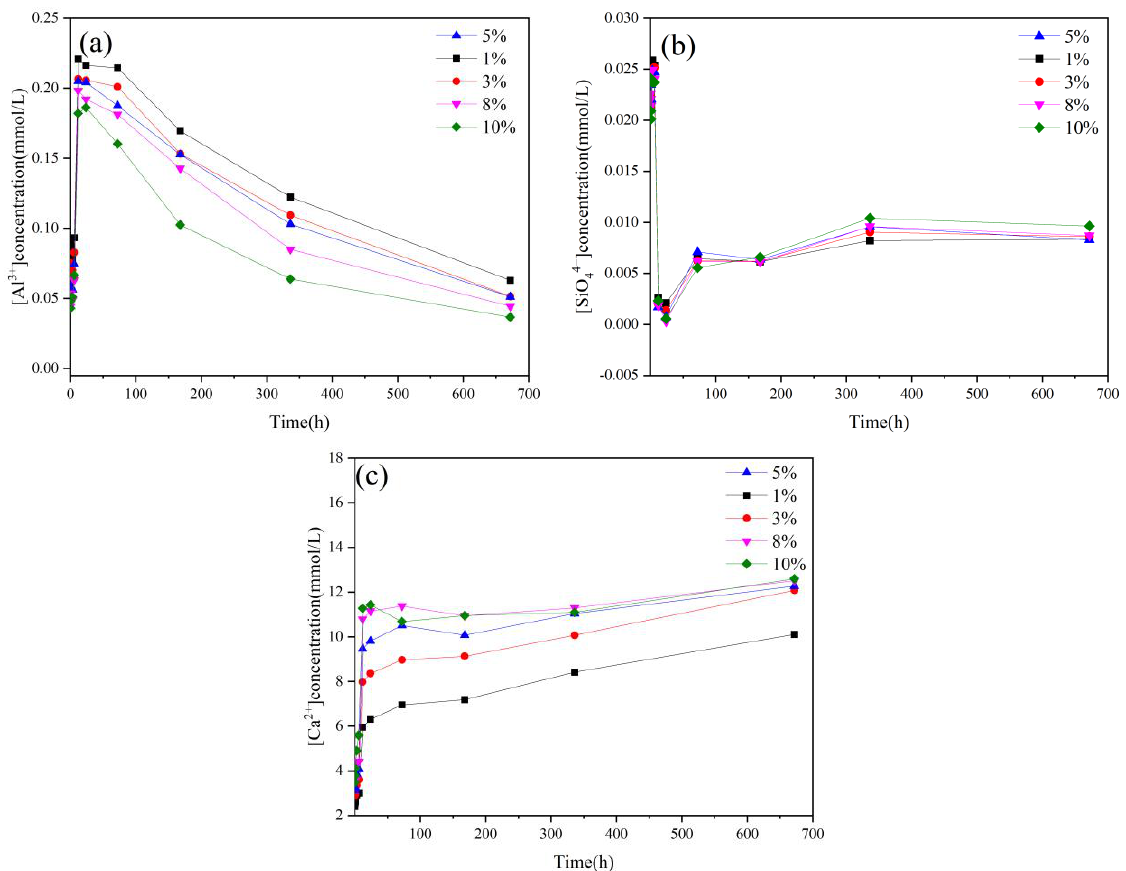
Figure 12. Ionic concentration of binders: ( a ) Al 3+ ; ( b ) SiO 44 − ; and ( c ) Ca 2+ .